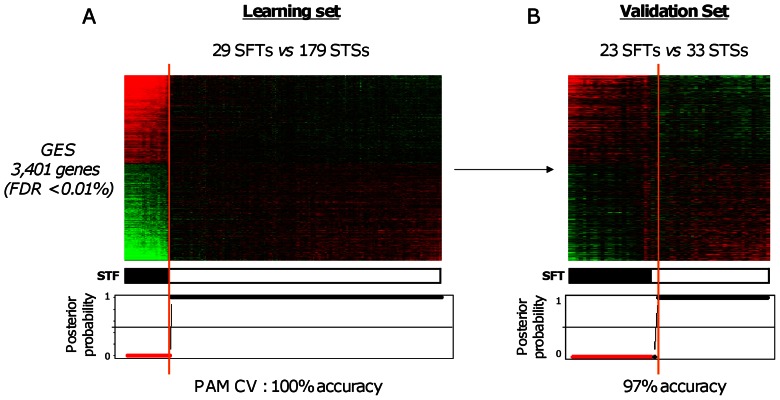
Supervised analysis of SFTs and all STSs.
A. Classification of 208 samples (29 SFTs and 179 STSs) from the learning set using the 3,401-gene expression signature. Top, matrix of gene expression data. The legend is similar to Figure 1A. Tumor samples are ordered from left to right according to the decreasing correlation coefficient of their expression profile with the mean profile of the SFT samples. The genes are ordered form top to bottom according to their decreasing SAM statistics of SFT association. Middle: actual histological type (black, SFT; white STS). Bottom, probability (from 0 to 1) for each sample to be predicted as non-SFT by the PAM model based on the signature. Red dots represent SFT samples, and black STS samples. The solid orange vertical line indicates the threshold of 50% (equiprobability according to PAM model) that separates the two signature-predicted classes of samples. B. Similar to A, but applied to the 56 samples (23 SFTs and 33 STSs) from the independent validation set.